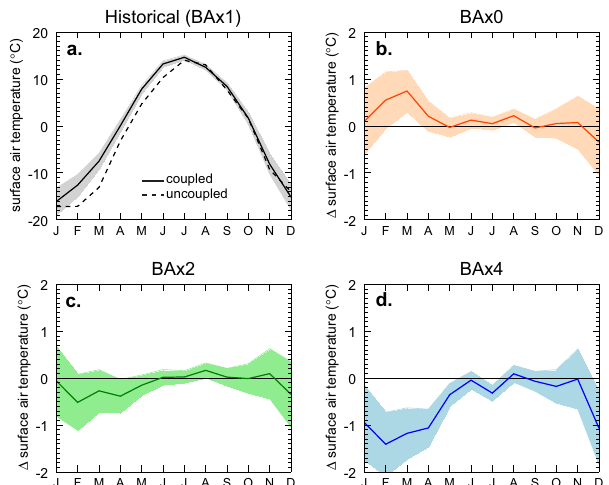
Fig. 6. Mean monthly historical (BA × 1) and changes to 2-m air temperature. The shaded area in (a) delineates monthly standard er- ror, and shaded regions in (b–d) represent monthly 95% confidence intervals. The uncoupled time series is driven by Qian et al. (2006) reanalysis data and used to assess temperature bias in the coupled